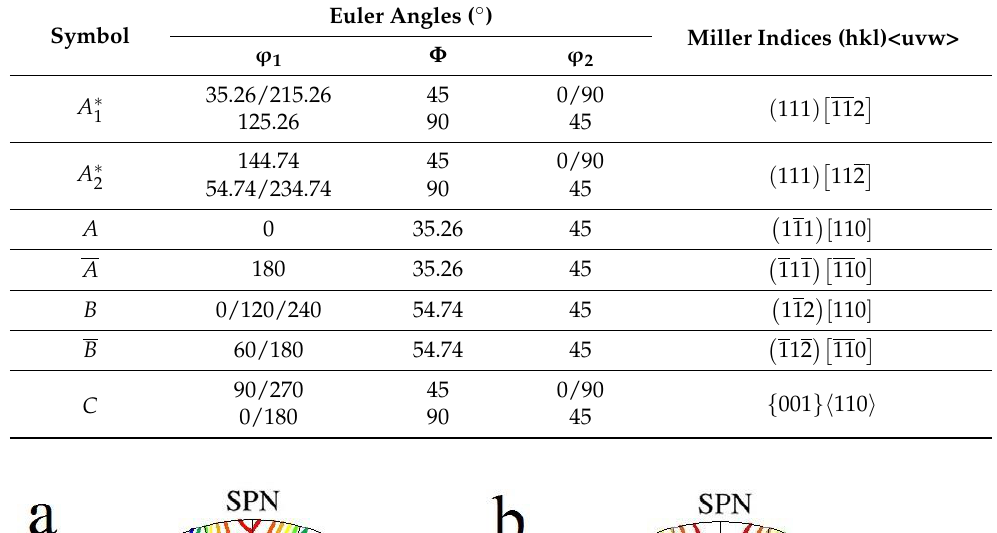
Table 1. Ideal texture components with corresponding Euler angles and Miller indices in simple shear deformation of metals with a face-centered cubic (FCC) crystallographic structure [6]. Euler Angles ( ◦ ) Symbol